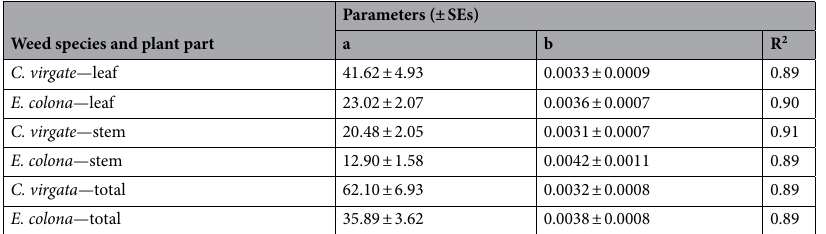
Table 2. Estimated parameters (± SEs) of a two-parameter exponential decay model, Y = ae −bx , fit to leaf, stem, and total shoot biomass per plant (g plant −1 ) of C. virgata and E. colona in competition with different densities (0, 82, 164, 246, and 328 plants m −2 ) of mungbean. a is a constant parameter, b is the rate of biomass reduction (slope), and R 2 is the coefficient of